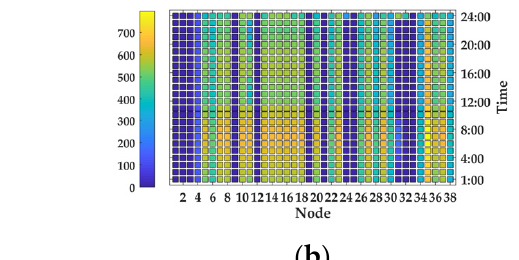
target year. ( a ) Weekdays, ( b ) Weekends.